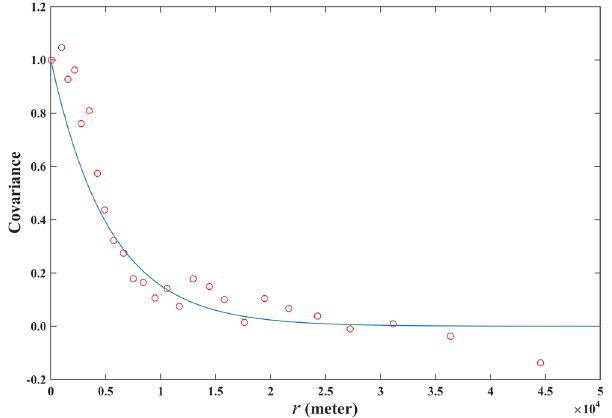
Figure 6. Empirical covariance (red dots) and theoretical covariance model (continuous line) of the traveling BC incidence distribution in R 2 .